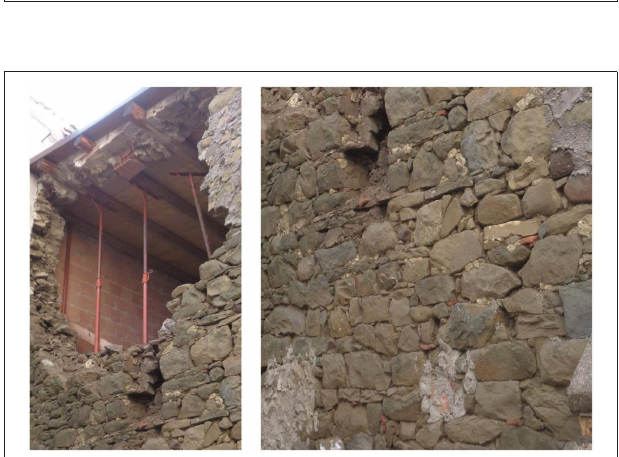
FIGURE 5 | Masonry typology mainly presents in Campotosto.